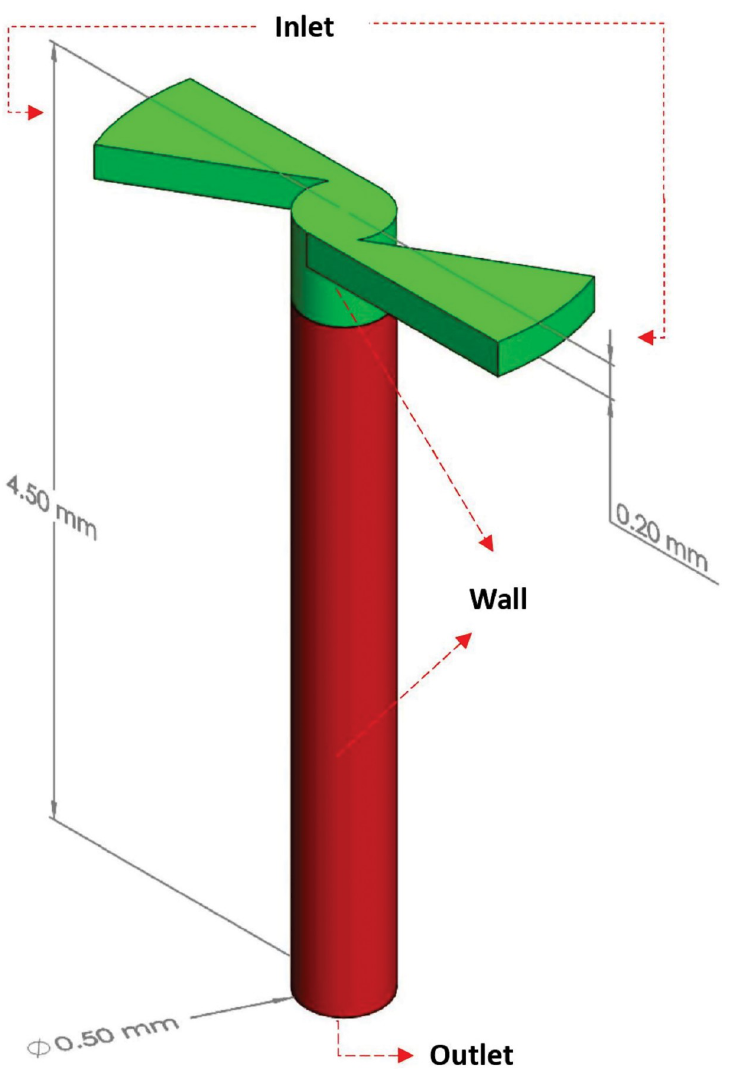
Fig 4. Computational domain illustration of the nebulizer